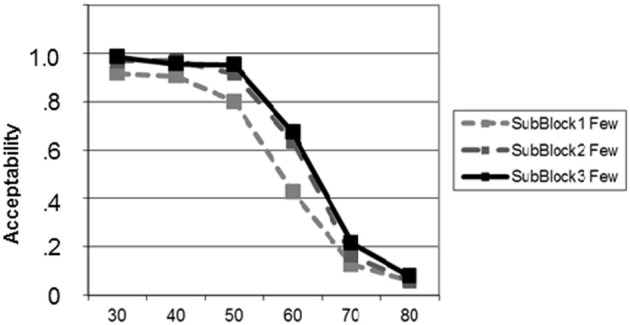
Learning curves for the new meaning of “few” during the adaptation phase (block 2), plotted separately for each of the three sub-blocks. Learning effects for proportions 50 and 60 are visible.